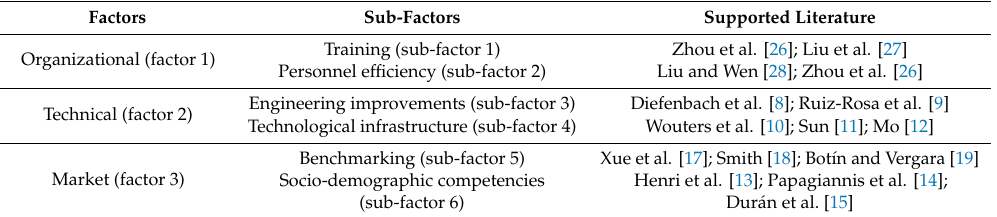
Table 1. Factors of sustainable low-cost industrial CO 2 capture and separation